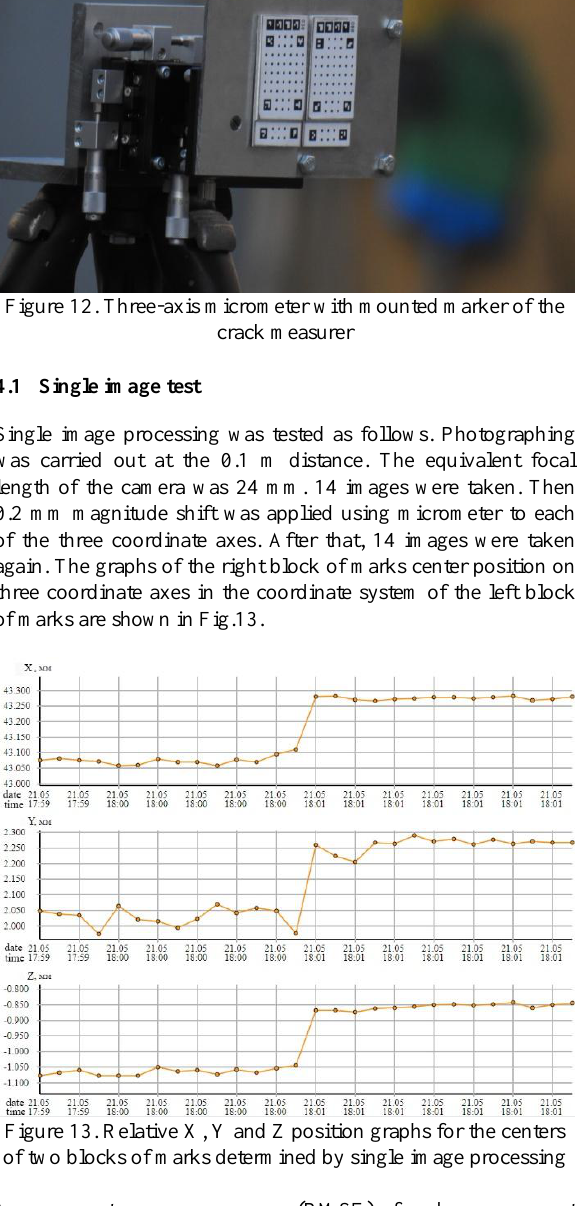
Figure 13. Relative X, Y and Z position graphs for the centers of two blocks of marks determined by single image processing Average root mean square error (RMSE) of each measurement along the X-axis did not exceed 0.029 mm, and accordingly 0.086 mm along the Y-axis, and 0.018 mm along the Z-axis. Standard deviations estimated basing on 14 measurements were 0.009 mm for X-axis, 0.026 mm for Y-axis, and 0.010 mm for Z-axis. Corresponding offsets were 0.205 mm for X-axis, 0.232 mm for Y-axis, and 0.210 mm for Z-axis. Obtained results are clearly reflect the shift of marks performed during the photographing taking into account accuracies of the micrometer and of the photogrammetric measurements.